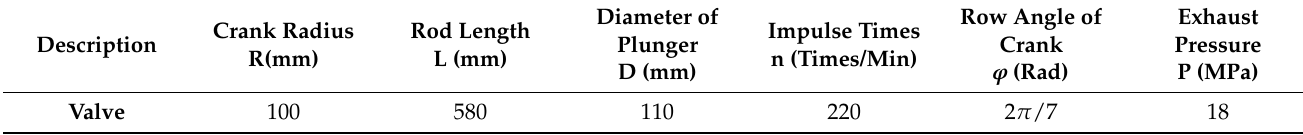
Table 1. Seven opposed plunger pump structure and working